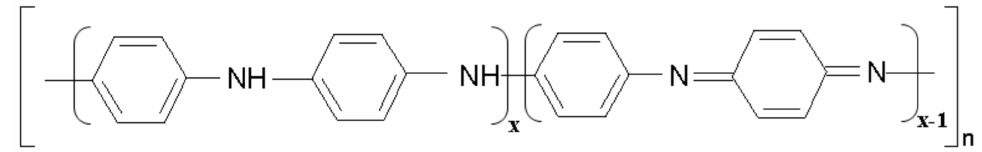
Figure 1. General structure of